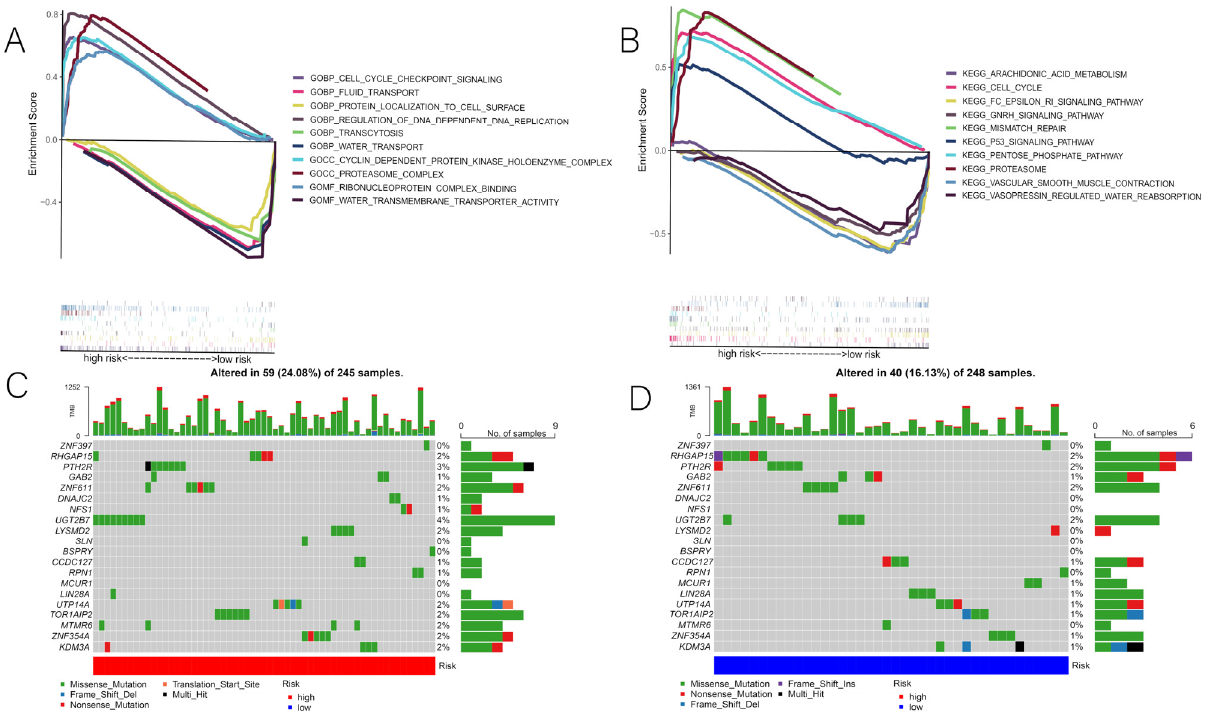
Figure 7. ( A , B ) Results of the GSEA analysis. ( C , D ) The top 20 driver genes with the highest mutation frequencies in the low-risk and high-risk groups.